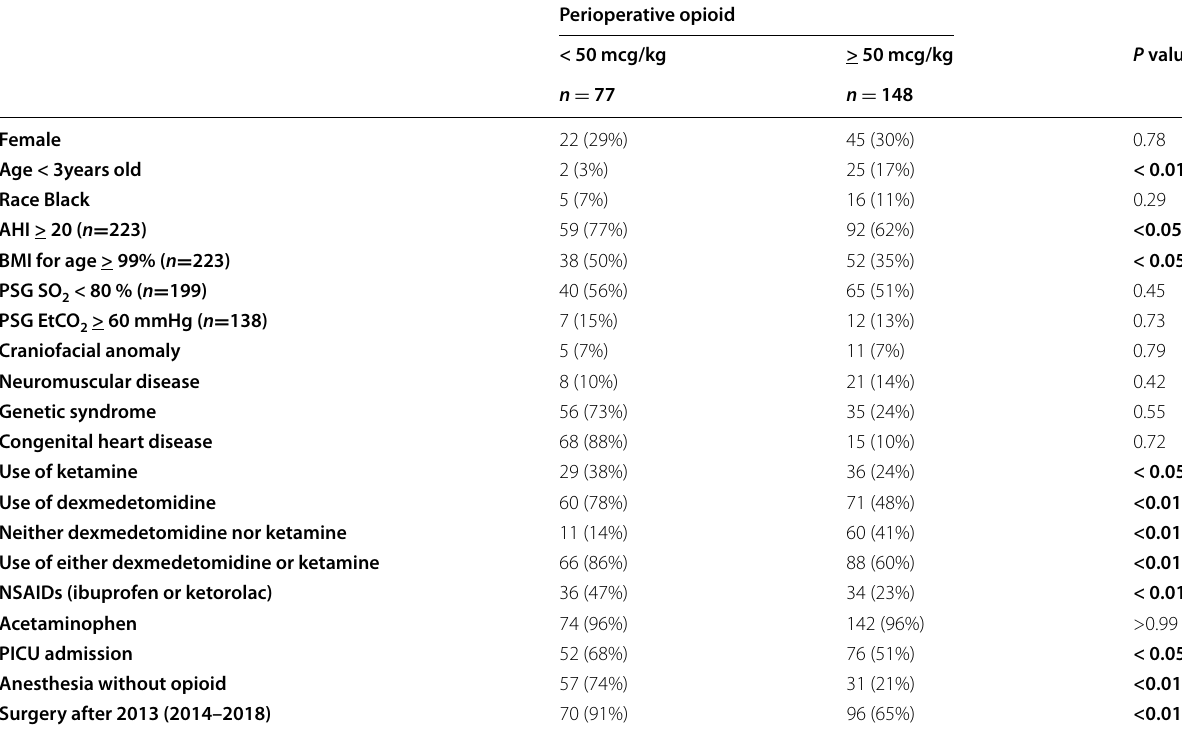
Independent association with the perioperative opioid avoidance (< 50 mcg/kg) of each perioperative factor was analyzed with chi‑square or Fisher’s exact test for categorical variables and the Mann‑Whitney U test for continuous variables. Variables with a univariable association P < 0.10 were used as candidate variables in